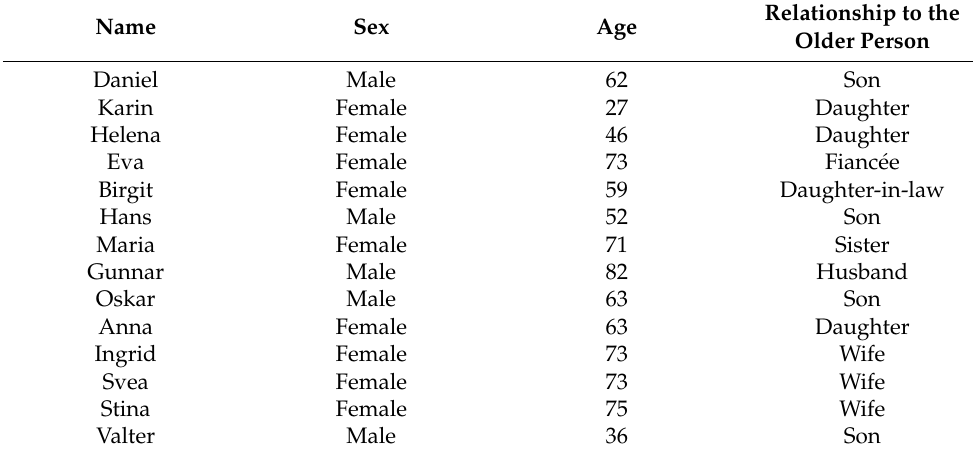
Table 1. Information about the